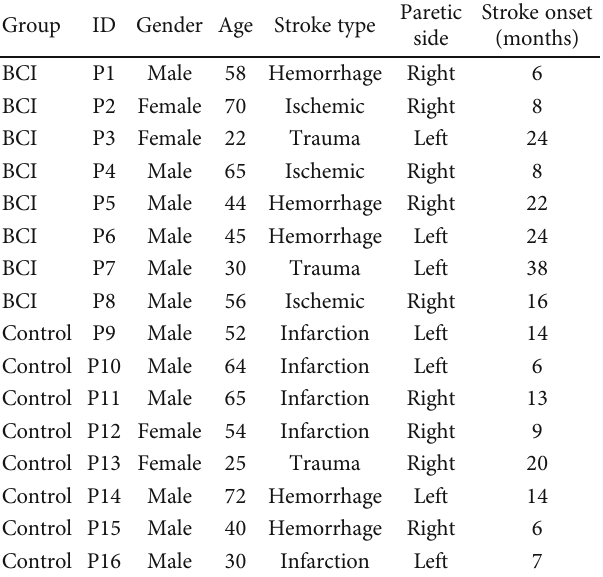
Table 1: Demographic information about the participants. Group ID Gender Age Stroke type